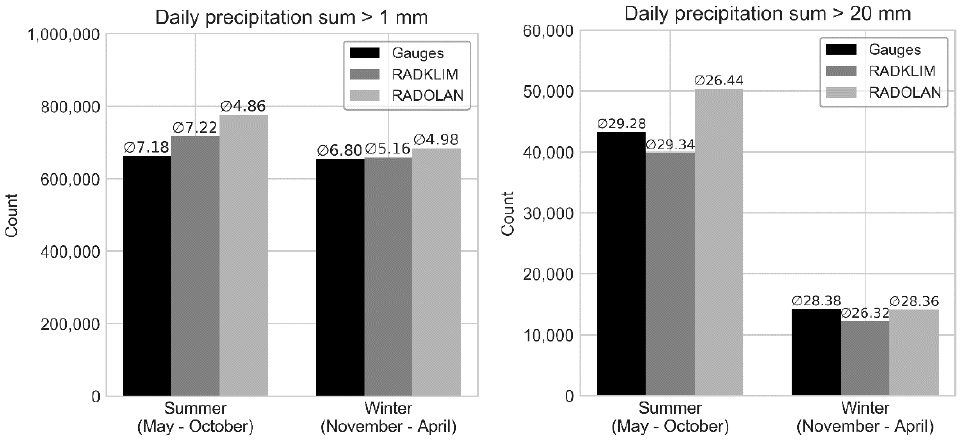
Figure 9. Number of days with precipitation amounts >1 mm ( left plot ) and >20 mm ( right plot ) in summer and winter half-years for gauges, RADKLIM and RADOLAN data. The numbers above the bars indicate the average daily precipitation sum of all days exceeding the respective threshold.